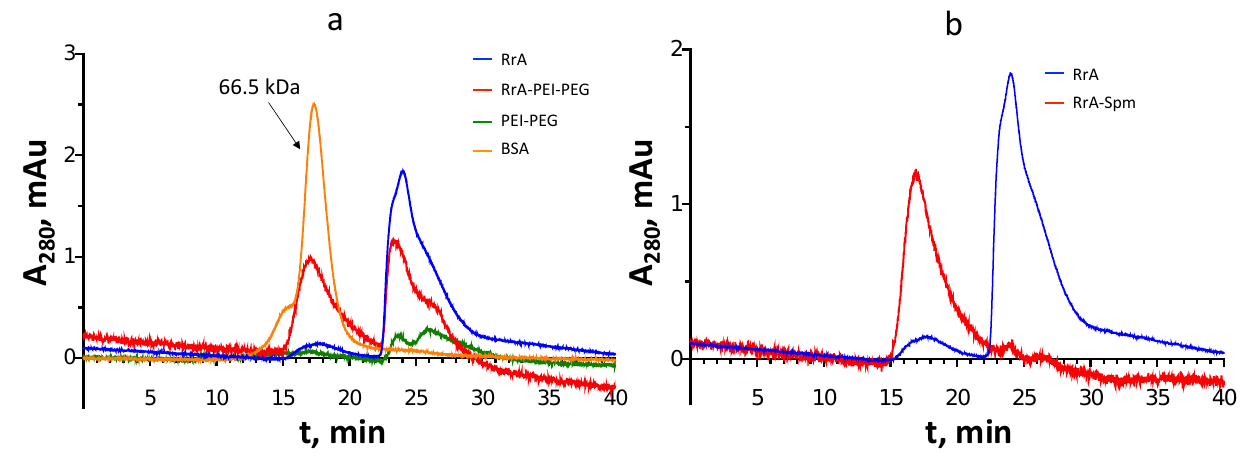
Figure 2. Chromatograms obtained by gel filtration: ( a ) solutions of RrA and conjugate, RrA-PEI- PEG; ( b ) native RrA and conjugate, RrA-Spm. Protein concentration of the samples is 1 mg/mL; C(PEI-PEG) = 5 mg/mL. Table 2. Retention times for the main fractions of native RrA solutions and their conjugates. RrA